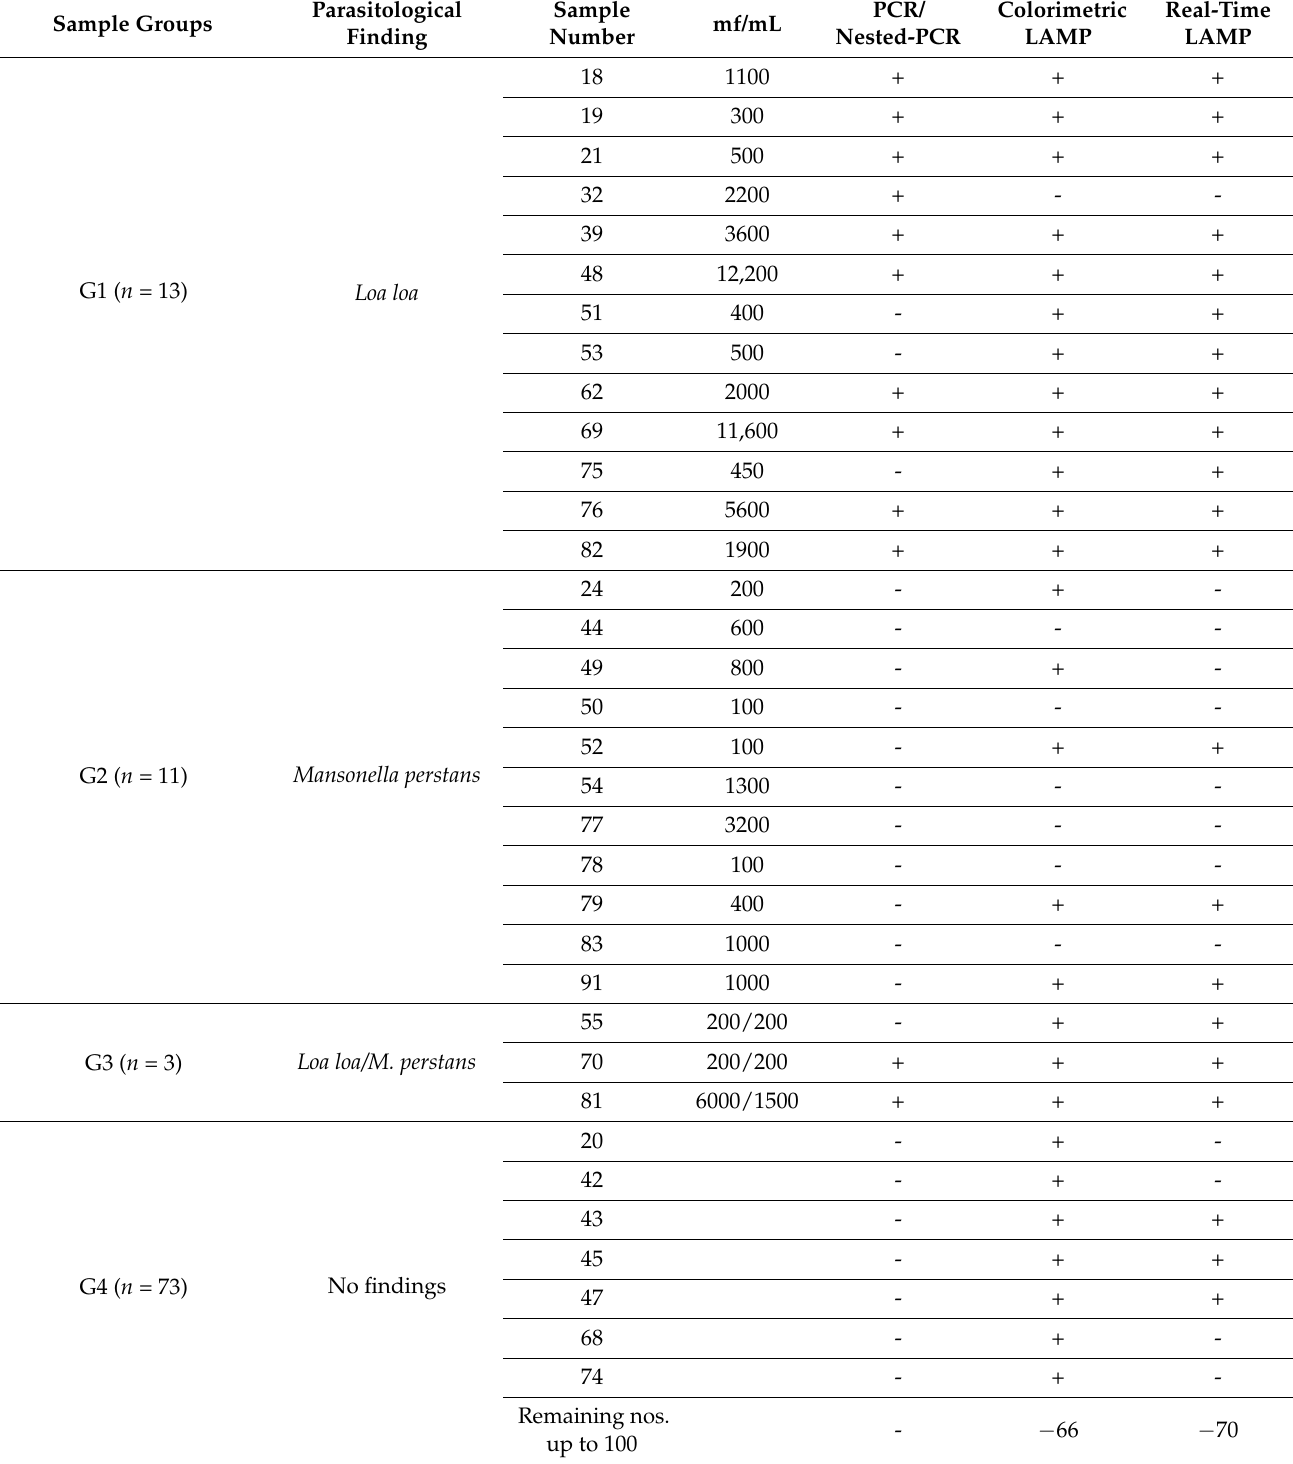
Table 1. Dried blood samples included in this study. Sample groups (G1, G2, G3, and G4), para- sitological findings based on microscopy of thick and thin blood smears with Giemsa stain, sample numbers and microfilariae counts (expressed as microfilariae per milliliter of blood; mf/mL) are indicated. PCR/nested-PCR, colorimetric and real-time LAMP results obtained in this study are also